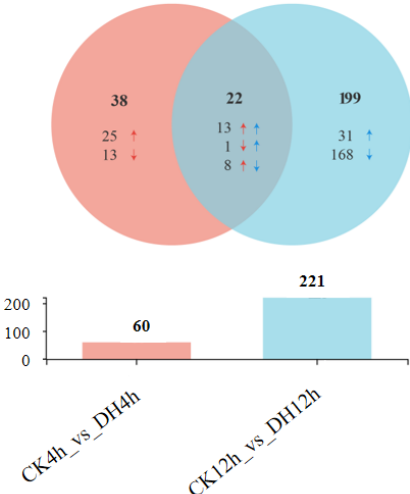
Figure 2. Volcano plot of DEGs identified in ovaries at 4 h ( a ) and 12 h ( b ) after DH injection. X -axis: log2−fold change (treatment/control). Y -axis: log10(FDR). Red data points indicated up-regulated unigenes and green data points indicated down-regulated unigenes.